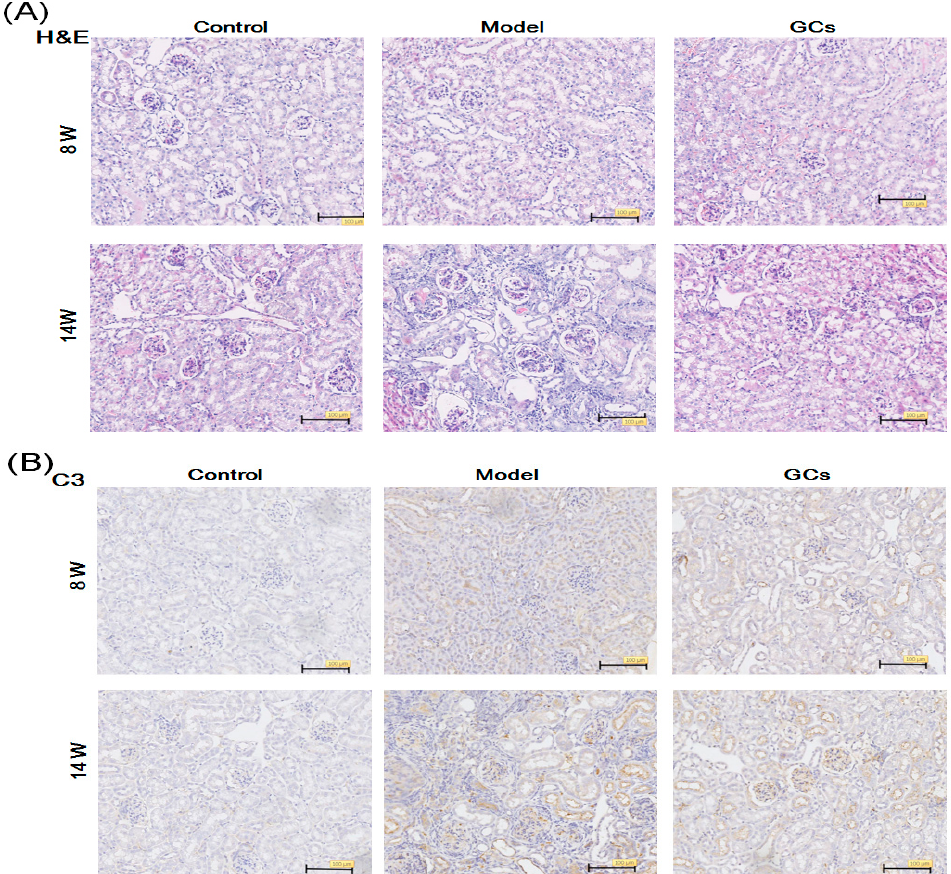
Figure 1. Comparison of renal histopathology of MRL/lpr mice from different groups. Kidney samples of the control ( n = 4), model ( n = 4), and glucocorticoids (GCs) ( n = 4) groups were collected at 8- (pre-lupus nephritis (pre-LN) state) and 14-weeks age (lupus nephritis (LN) state), respectively. Histopathological features of the mouse renal tissues were determined by H&E staining (Panel A ). The C3 deposition in glomeruli was assessed by immunohistochemical staining (Panel B ). All representative images were captured under × 100 visual field. H&E denotes hematoxylin and eosin. C3 represents Complement C3.